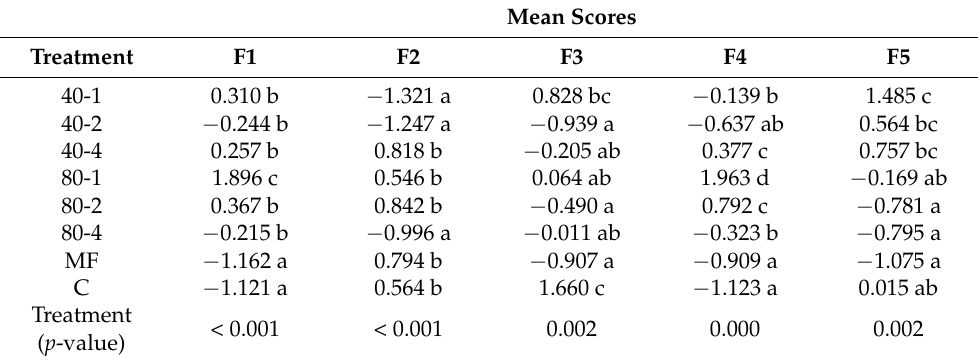
Table 7. Effect of treatment on factor scores from PCA ( p < 0.05).